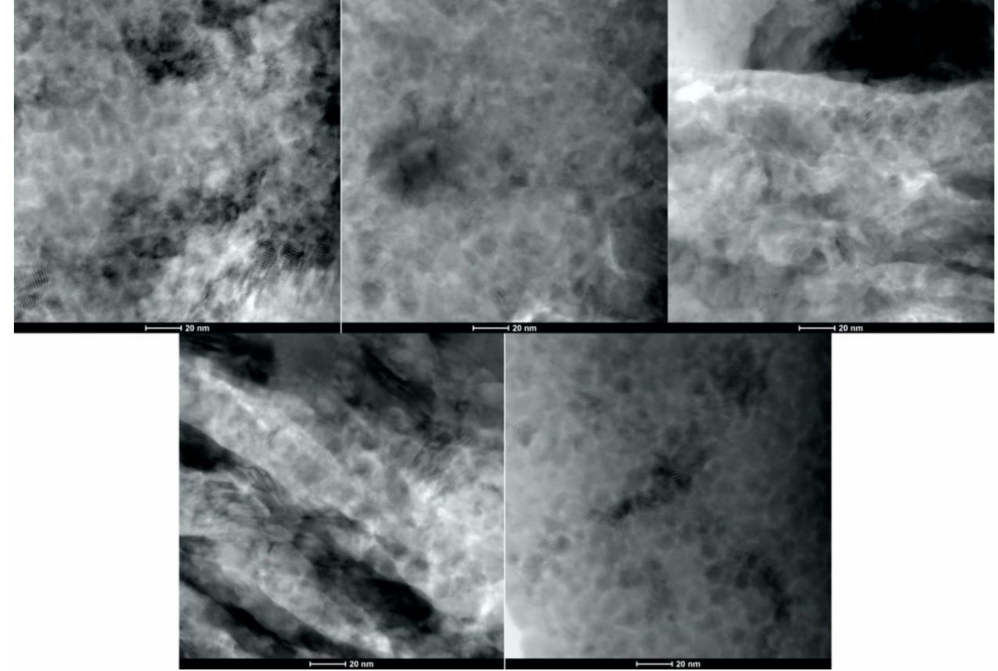
Figure 22. STEM micrographs of the deformed microstructure of the nanostructured cold sprayed coatings in the cross-sectional orientation. Note that the scale bar represents 20 nm. Limited presence of dislocation defects within the regions captured in the middle micrograph on the top row and bottom right micrograph. Numerable nanoparticle / nanoparticle boundaries and interiors can be observed in the same micrographs. Elongated and deformed grains are present within the bottom left and upper right